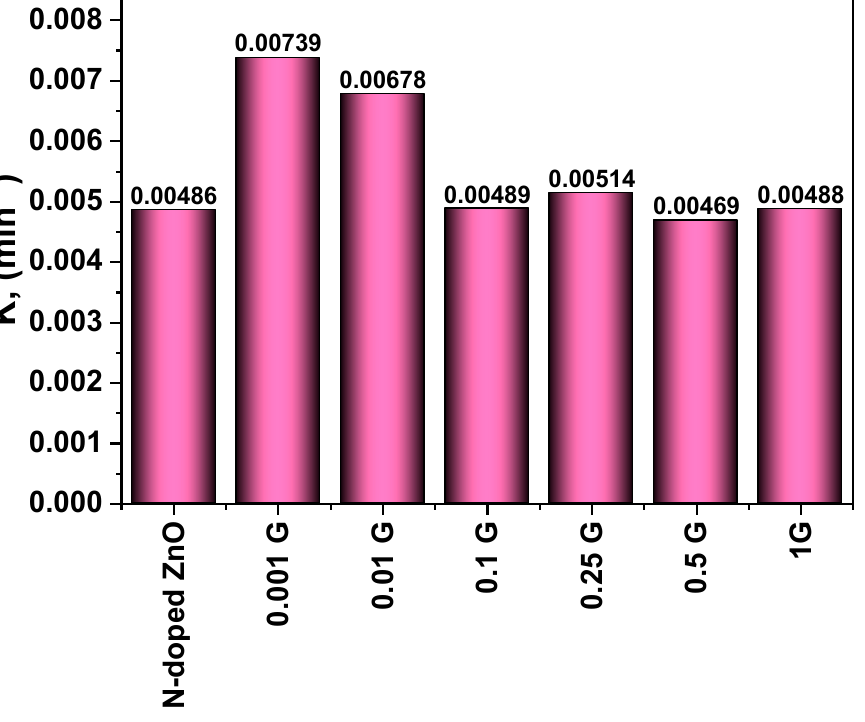
Figure 5. Rate constant values of carmine dye in situ with pure N-doped ZnO and six different concentrations of graphene using the photocatalytic degradation method. Table 2. Rate constants (min − 1 ) and degradation (%) for all photodegradation reactions under various